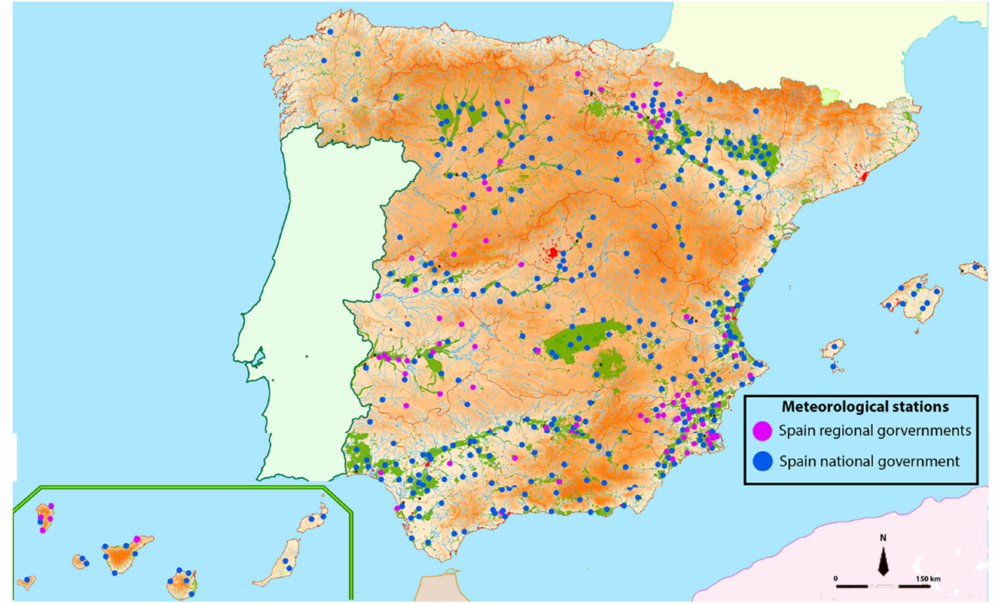
Figure 1. Meteorological stations of the Agroclimatic Information System for Irrigation (SIAR) in Spain